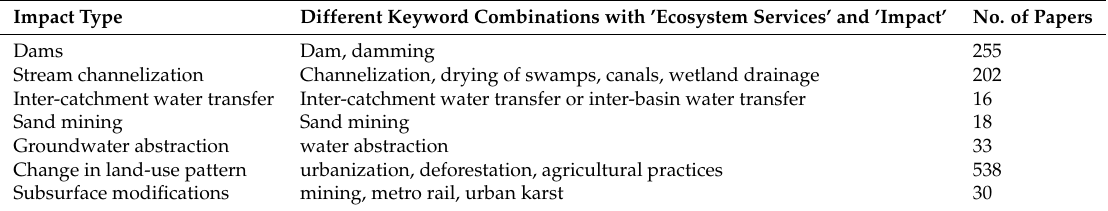
Table 1. Different keyword combinations for the literature search before inclusion criteria were applied. Impact